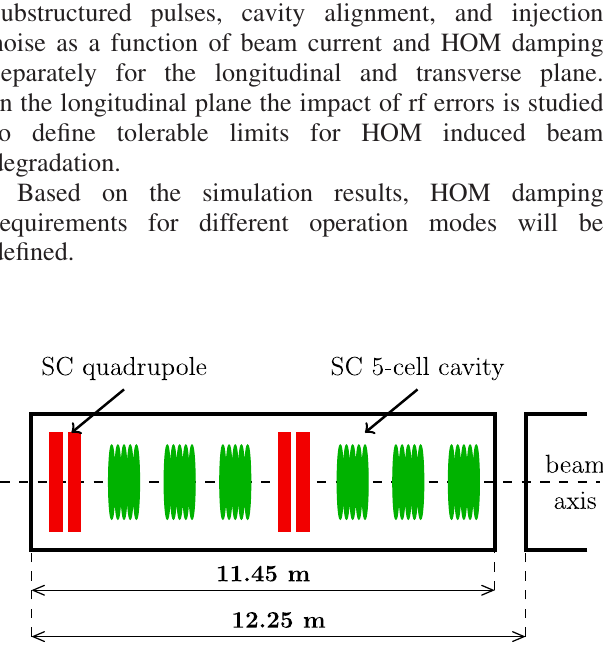
FIG. 1. Period layout in the medium beta